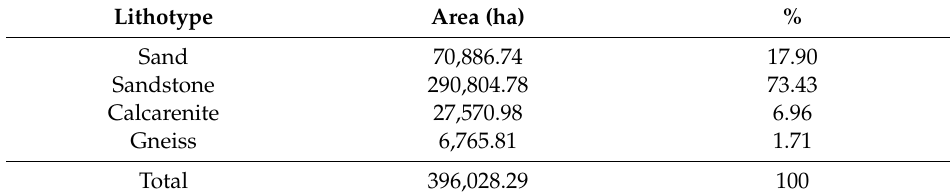
Figure 3. Lithological map of the Pandeiros River basin. Table 3. Spatial distribution and proportion of lithotypes in the Pandeiros River basin.